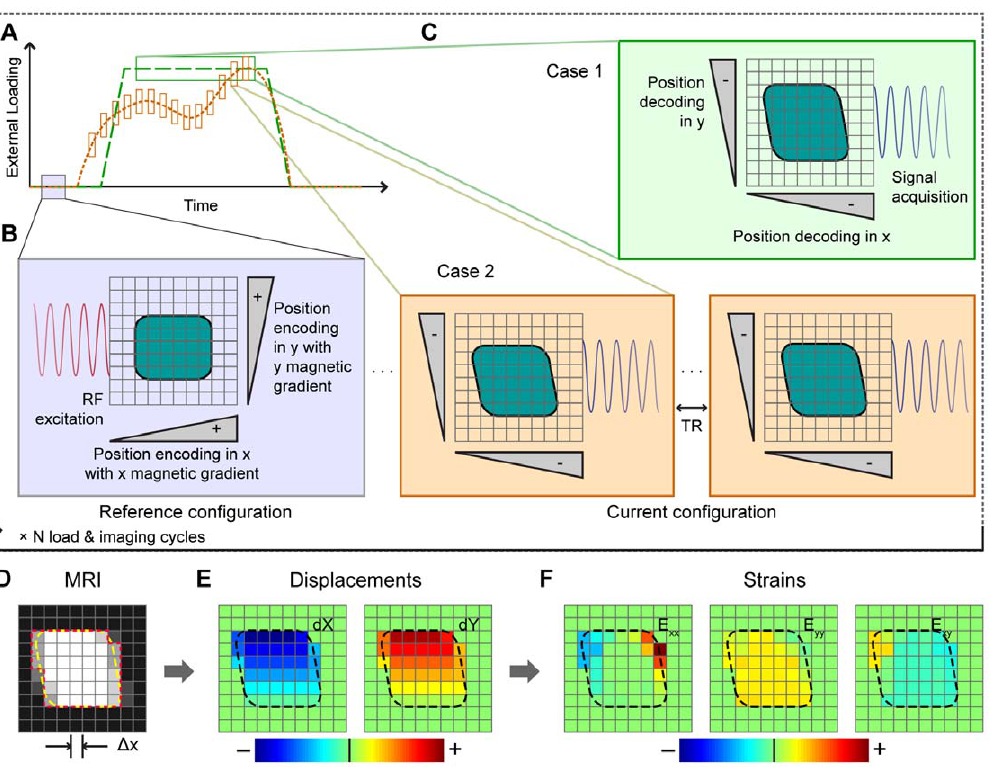
Figure 1. Synchronized loading and imaging for the calculation of displacements and strains using displacement-encoded MRI. Various cyclic loading regimes, including a plateau of constant load (Case 1 – long dashed green line) and a time-transient loading scheme (Case 2 – short dashed orange line) are synchronized with displacement-encoded MRI actions ( A ). Within each loading and imaging cycle, the reference configuration is encoded using radiofrequency (RF) excitation and a linear magnetic gradient ( B ). In the current deformed configuration, the new position of the material is decoded by applying another linear magnetic gradient, and signal encoded with the change in position is acquired ( C ). For Case 1, position decoding and acquisition occurs throughout the load plateau. For Case 2, decoding and partial acquisitions occur during shorter time periods within the loading scheme to produce time-resolved frames of MRI data. This acquisition scheme requires many more loading cycles but produces MRI data at frame rates limited only by TR. The spatial resolution, D x ( D ) determines the volume over which displacements ( E ) and strains ( F ) are computed for each pixel.